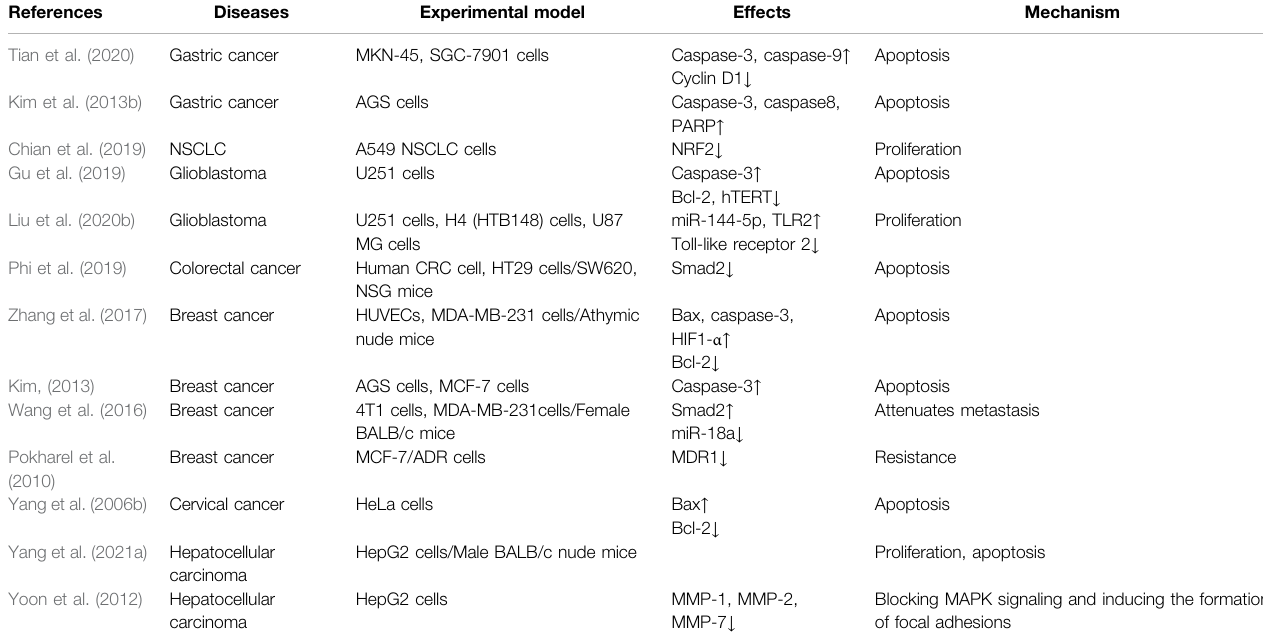
TABLE 3 | Summary of the effects and mechanisms of ginsenoside Rd on cell and animal models of multiple